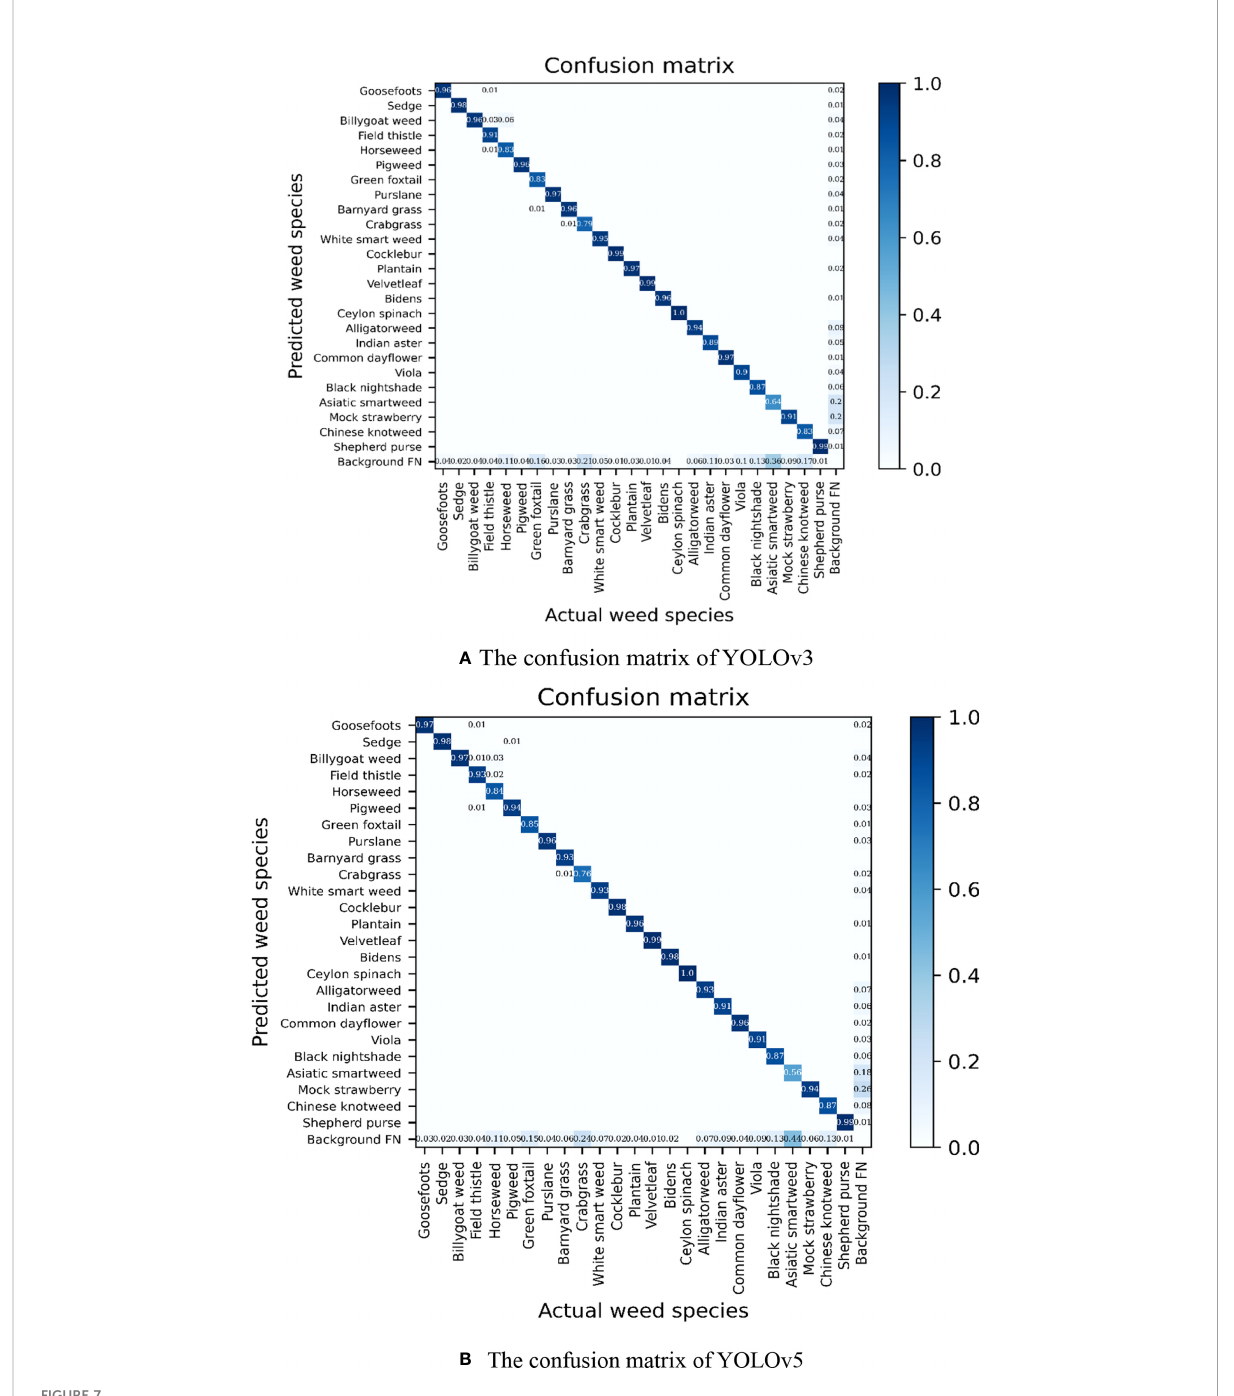
FIGURE 7 Confusion matrix of You Only Look Once